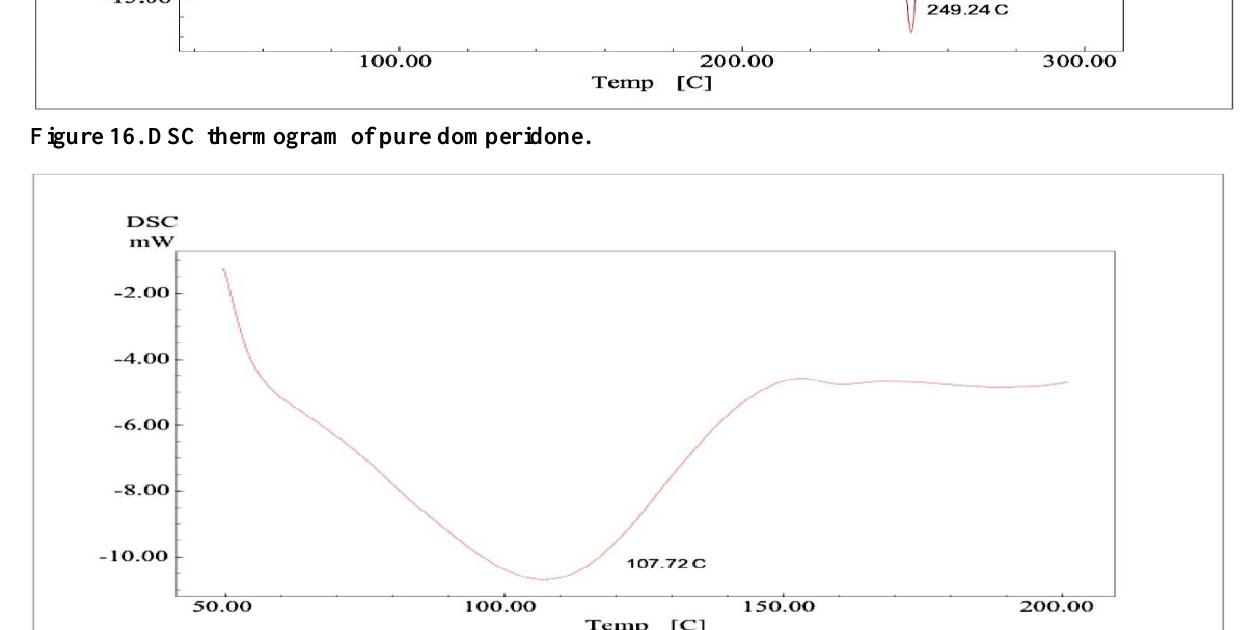
Figure 17. DSC thermogram of